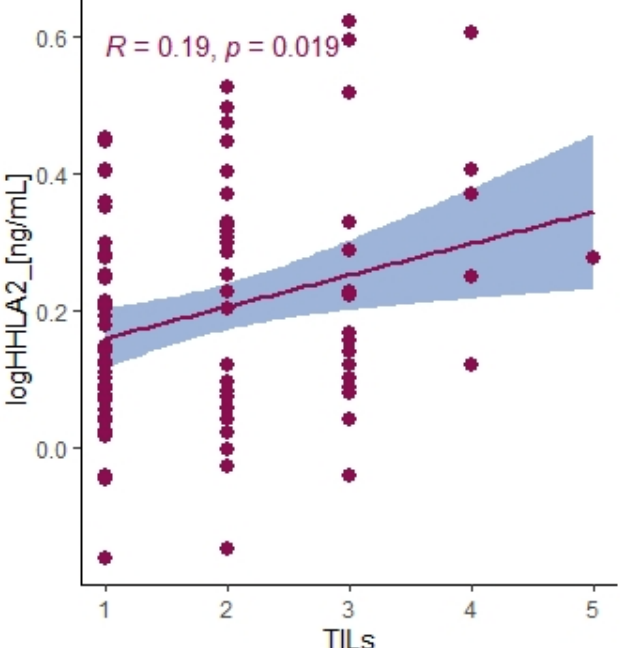
Figure 3. Correlation between HHLA2 concentrations in tumor tissue homogenates and TILs score. Tau Kendall correlation coefficient.